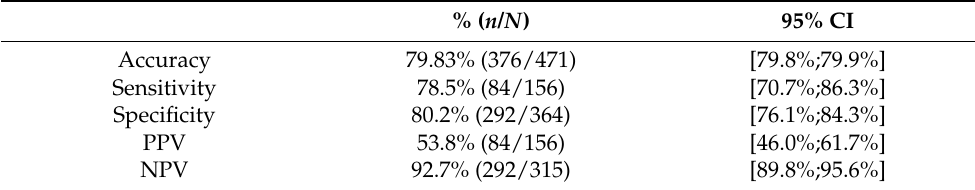
Table 2. Sensitivity, specificity, positive predicted value (PPV), negative predicted value (NPV)